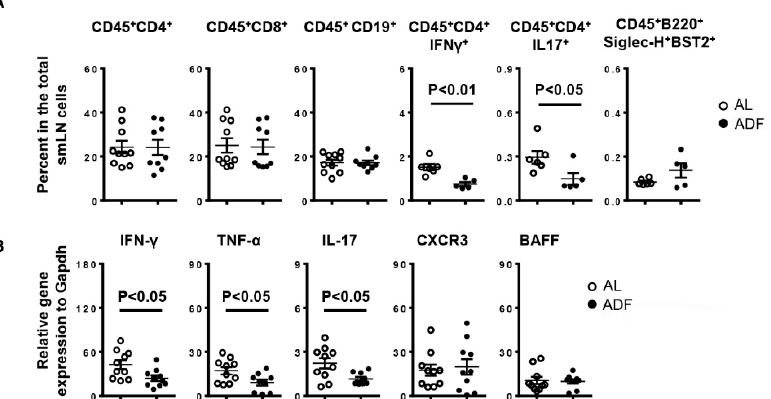
Figure 4. Alternate-day fasting (ADF) decreases the proportion of Th1 and Th17 cells without af- fecting that of total CD4 T-, CD8 T cells and B cells in the smLNs. 10-week-old female NOD mice were deprived of food every other day or fed with standard chow ad libitum (AL) for 3 weeks. ( A ) The average percentage of lymphocyte subpopulations among the smLN cells. ( B ) Real-time PCR analysis of T and B cell-associated genes, presented relative to that of GAPDH. Data are representa- tive or the average of at least 5–6 mice each group, with majority of the data generated from 9–10 mice from each group.